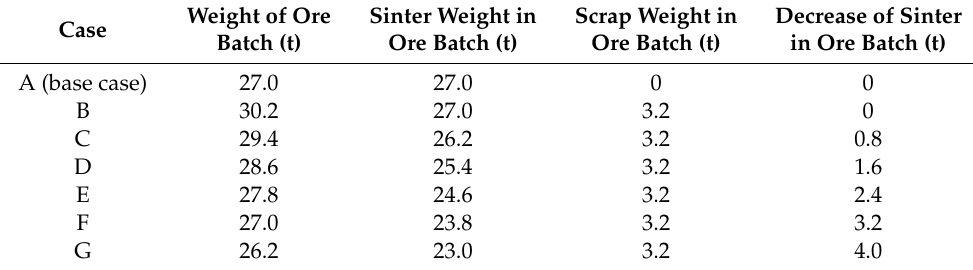
Table 3. Simulation conditions.